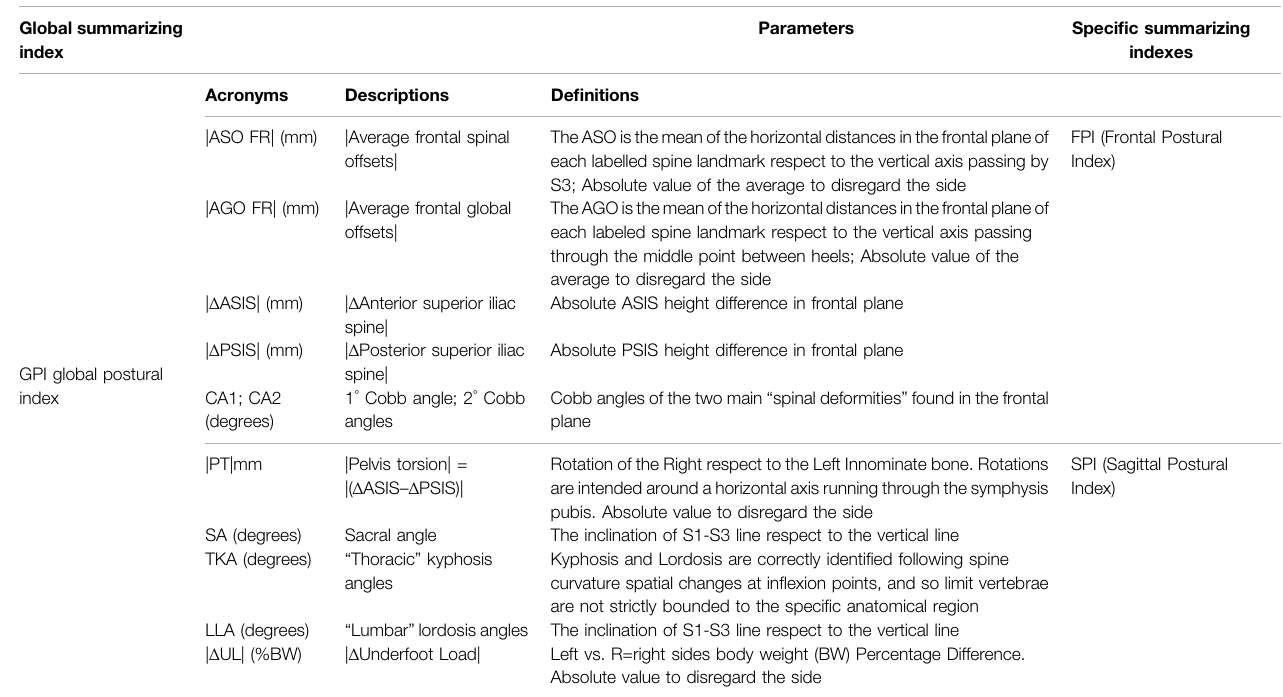
TABLE 2 | List of considered parameters (de fi nitions and corresponding acronyms) for IO vs. WCO comparison and Summarizing Indexes. Global summarizing